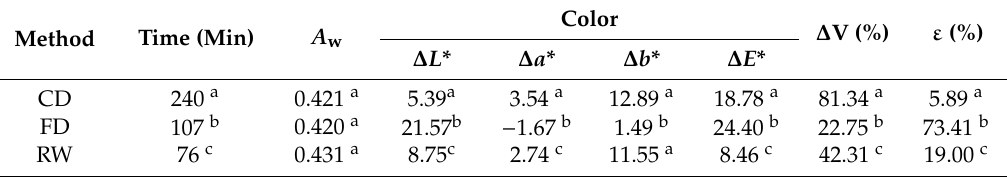
Figure 3. Drying curves of guava samples using convective drying (CD), freeze drying (FD) and refractance window drying (RW). Table 1. Changes in physical properties of guava samples dried by CD, FD and RW to moisture values of 0.040 ± 0.002 g water/g db.